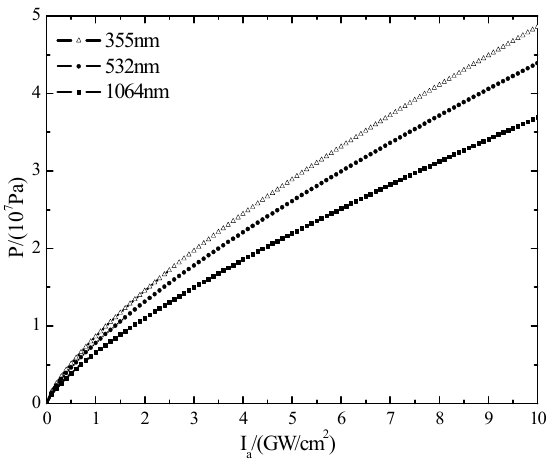
Figure 13. A diagram which shows the relationship of pressure laser wavelength and power density.